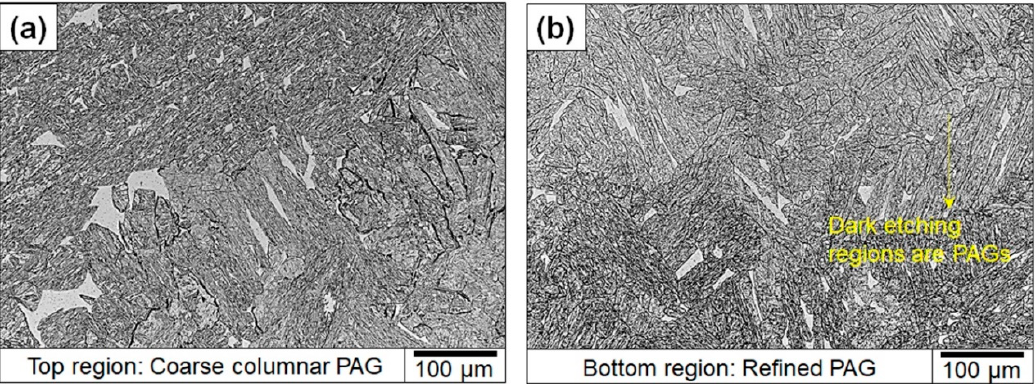
Figure 8. Optical micrograph showing differences in grain microstructure at ( a ) top and ( b ) bottom of the builds in as-printed condition.